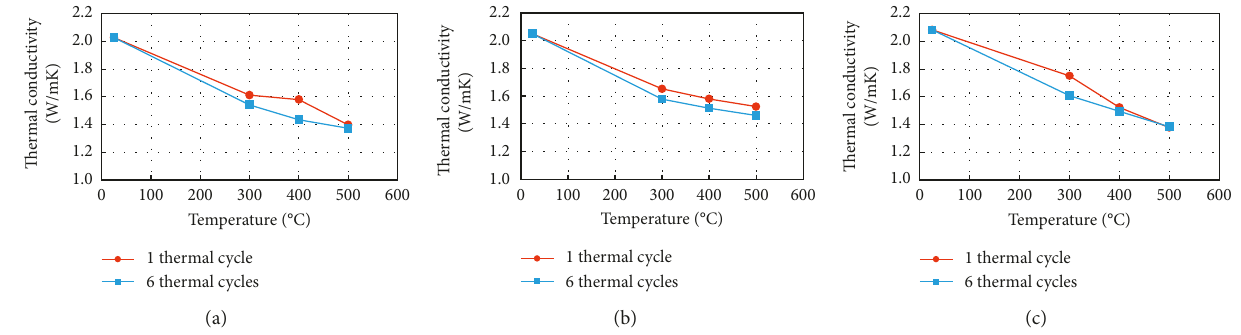
Figure 12: Comparison of thermal conductivities after one and six thermal cycles. (a) Steel fiber content � 1.0%. (b) Steel fiber con- tent � 1.5%. (c) Steel fiber content � 2.0%.